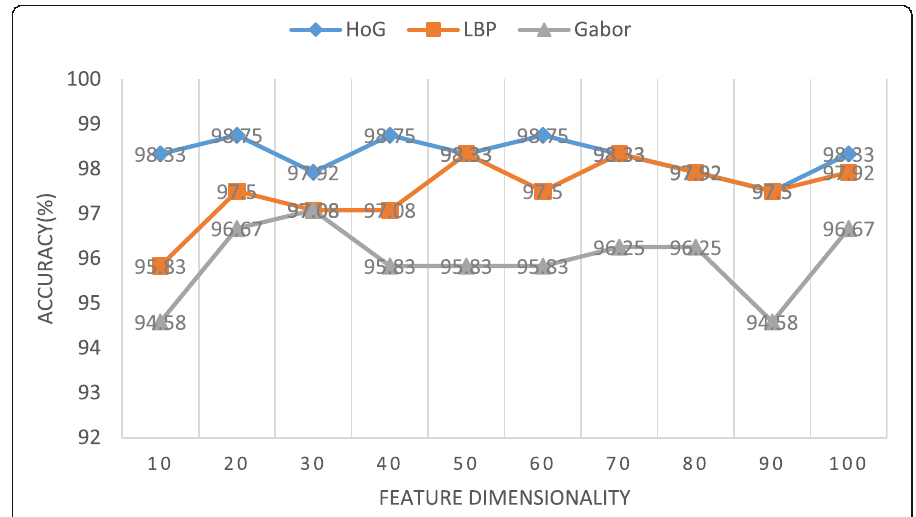
Fig. 7 Accuracy of person-dependent facial expression recognition according to feature dimensionality